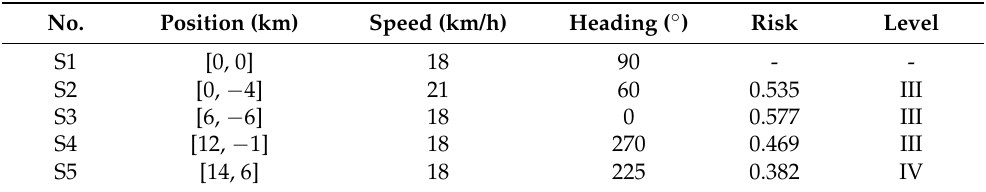
Table 5. Collision risk level.